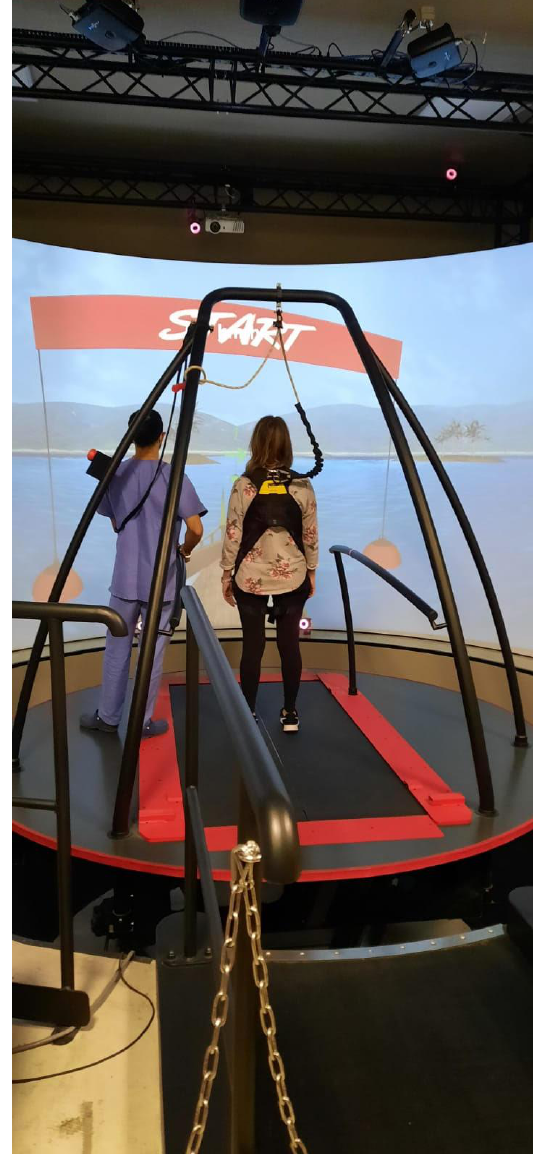
Figure 1. A screenshot of the patient undergoing a training session on the CAREN VR rehabilitation system.